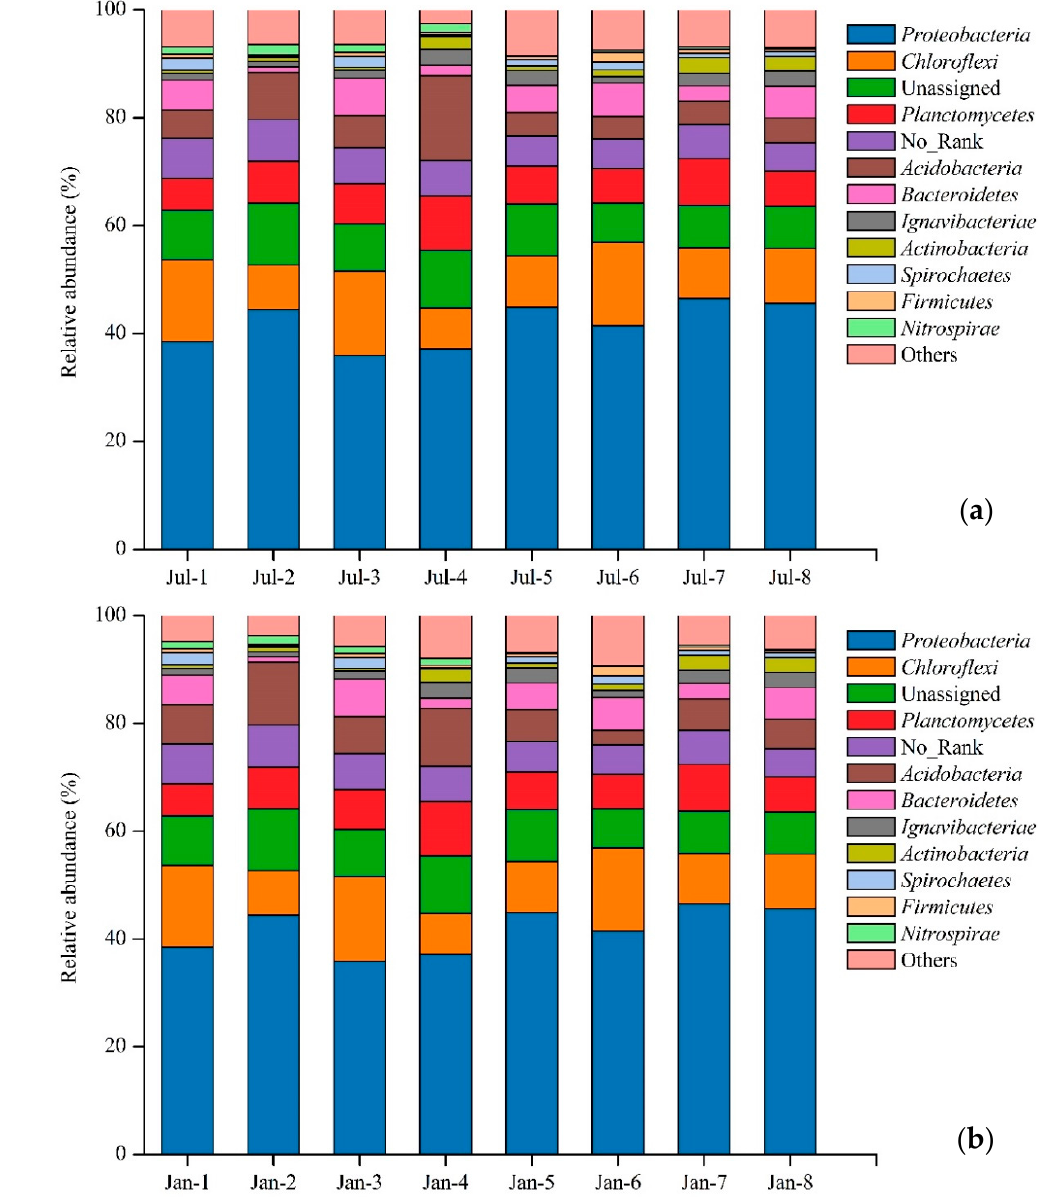
Figure 3. Bar chart of taxonomic profiles of bacterial community at the phylum level with abundance > 1% in July 2018 ( a ) and January 2019 ( b ).